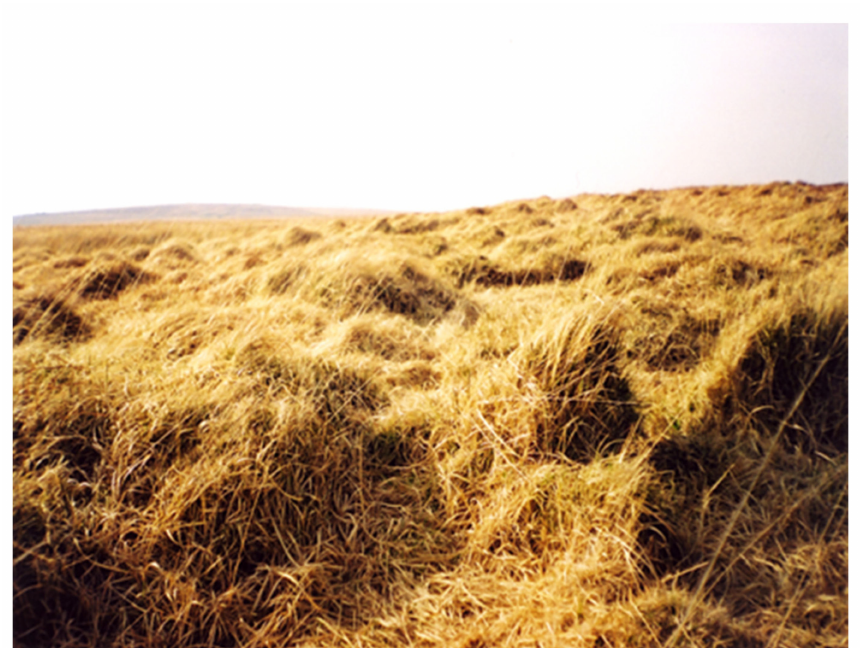
Figure 15. The Chains blanket bog, Exmoor, UK; dominated over large tracts by the deciduous grass Molinia caerulea which has contributed to active peat accumulation and was threatened by afforestation. Source: Edward